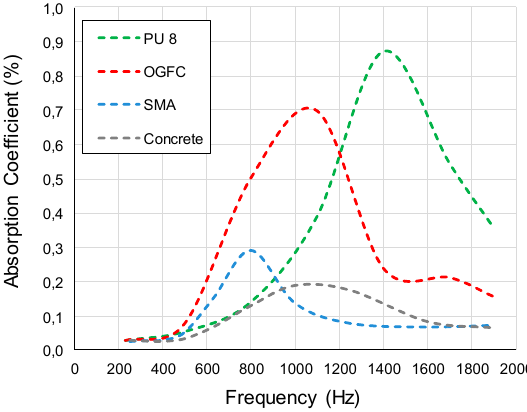
Figure 7. Acoustic absorption-coefficient curves.